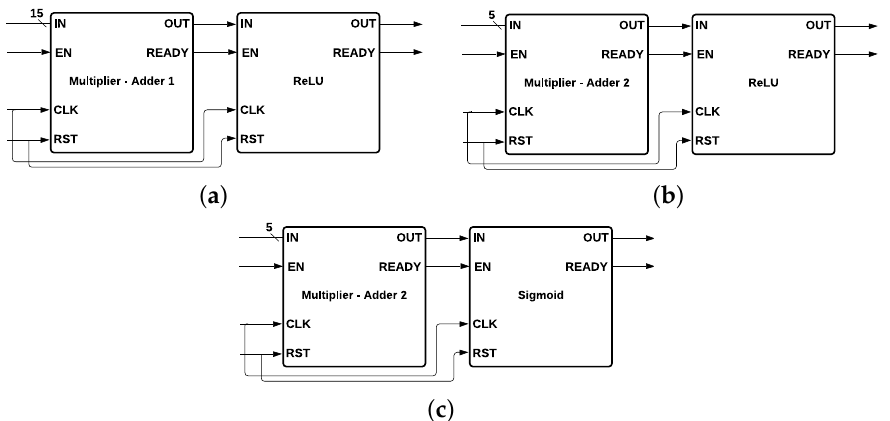
Figure 10. Neurons of the Feed-Forward Neural Network. ( a ) Neuron of the First Layer, 15-bit input and ReLU activation function; ( b ) Neuron of the Second Layer, 5-bit input and ReLU activation function; ( c ) Neuron of the Third Layer, 5-bit input and Sigmoid activation function.